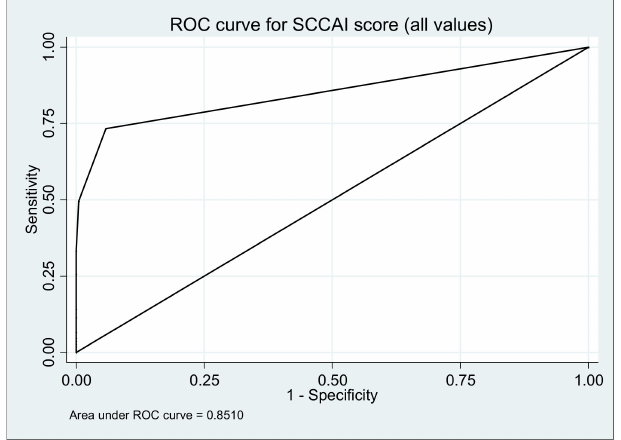
Figure 4. Area under the ROC curve to predict ulcerative colitis relapse using the Simple Clinical Activity Index of Ulcerative Colitis (SCCAI) score during 12 months.